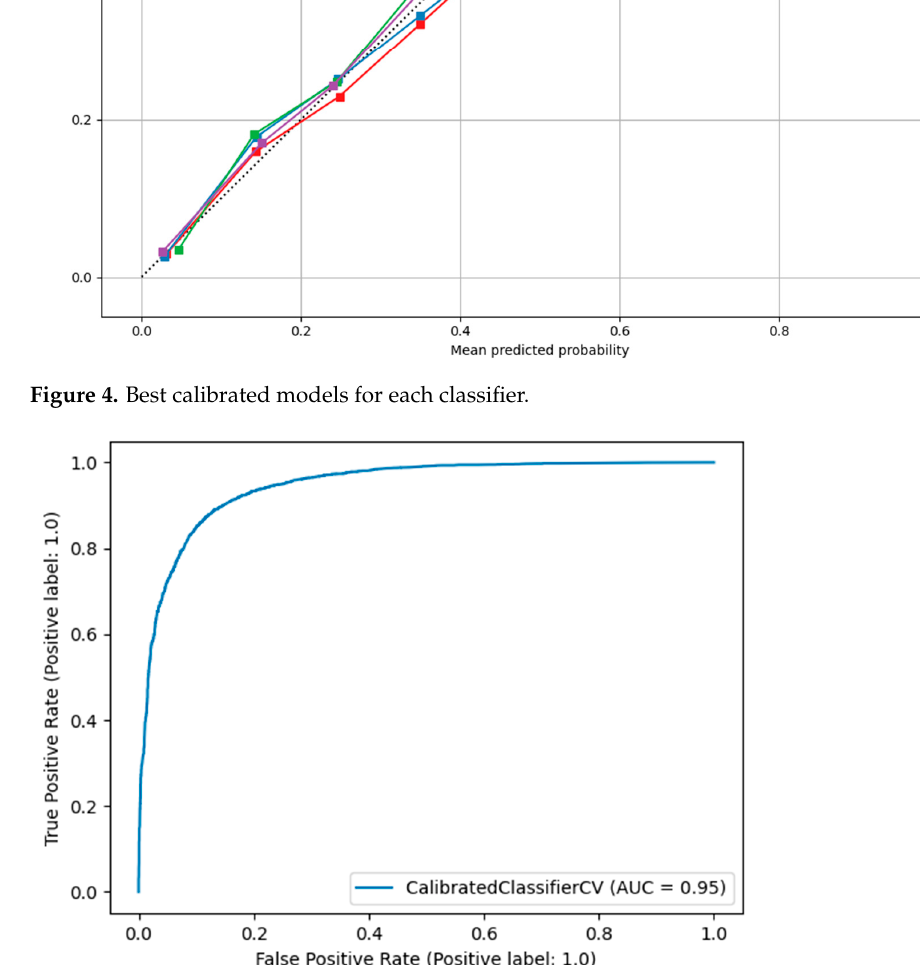
Figure 5. Roc curve of the LGBM + Isotonic model.